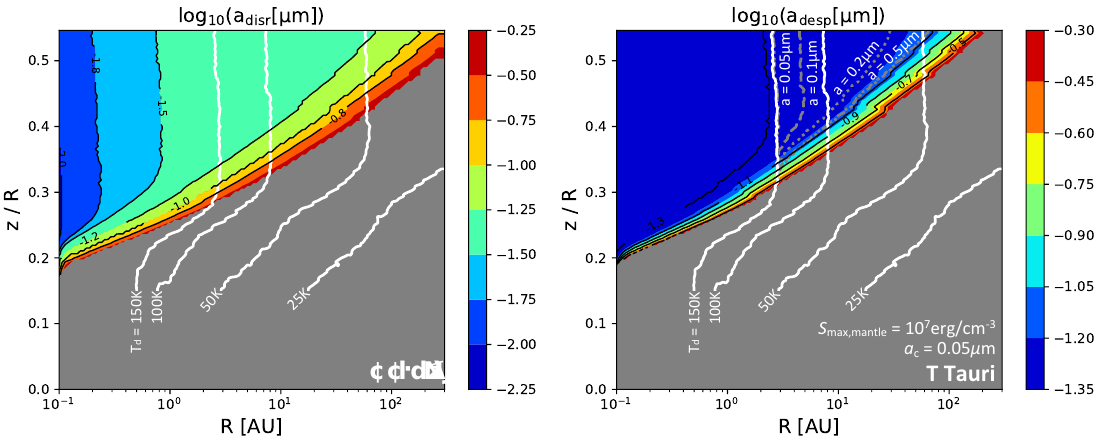
Figure 26. Left panel: Disruption sizes of composite grains for a protoplanetary disk around T-Tauri stars as a function of R and z / R . White lines show the locations of the disk that have T d = 150,100,50, 25K. Right panel: Desorption sizes of ice mantles for a PPD around T-Tauri stars as a function of R and z / R , assuming a fixed core radius a c = 0.05 µ m and the varying mantle thickness. Gray dashed and dotted lines illustrate the region where τ − 1 sizes a , assuming water ice of T sub =